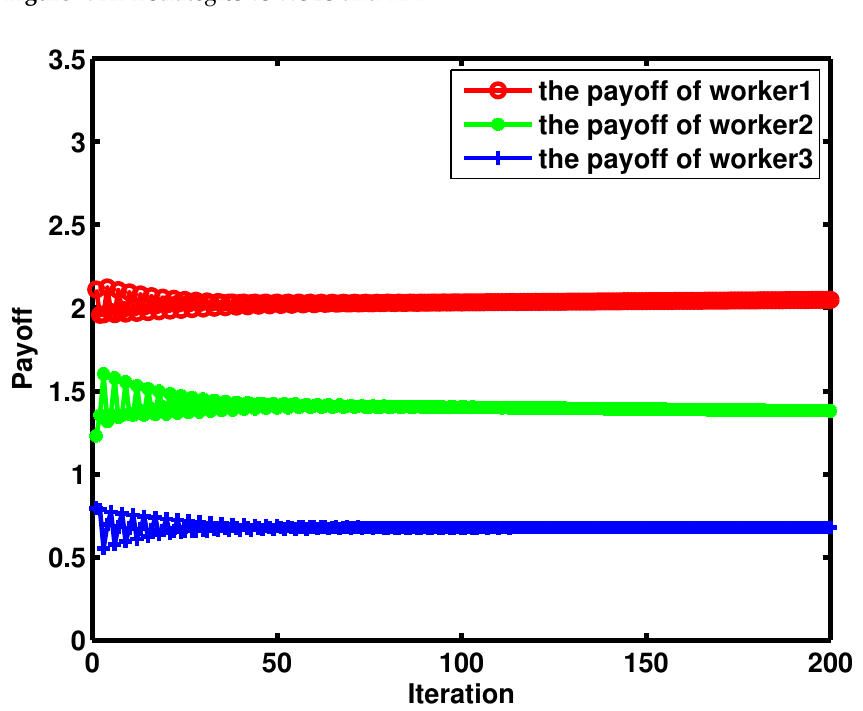
Figure 8. The payoff of 3 workers where worker 1 uses ZD3